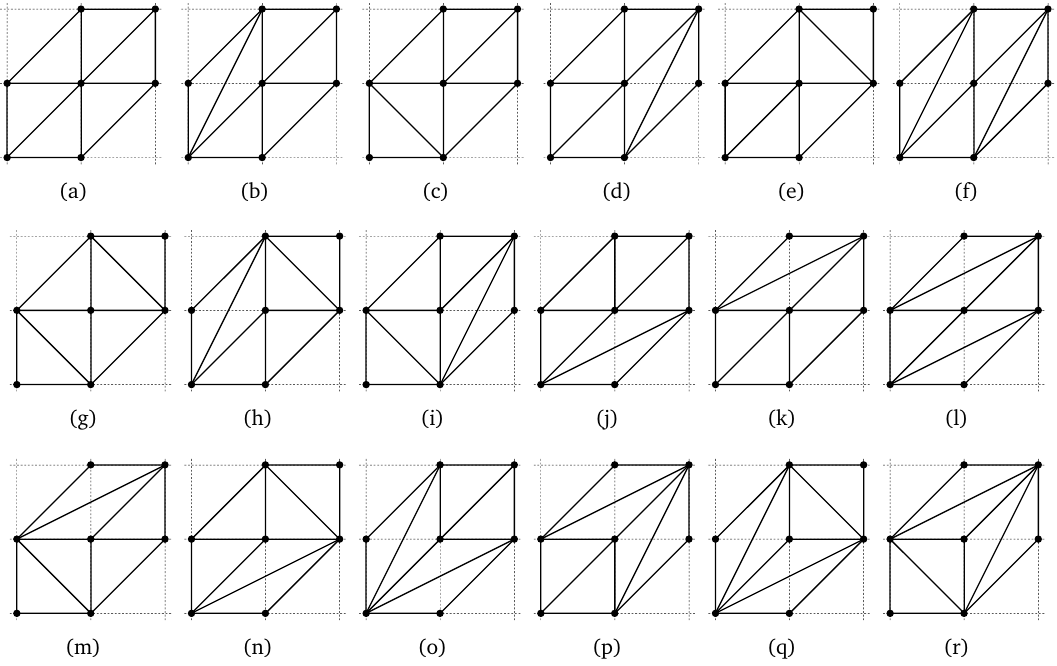
Figure 11: The 18 resolutions of the E singularity. The 9 resolutions (a)-(i) admit 3 a vertical reduction. There are also 9 resolutions that admit an horizontal reduction (namely: (a), (c), (e), (g), (j)-(n)), and 9 resolutions that admit an “oblique” reduc- tion (namely: (a), (b), (d), (f), (g)-(l), (o), (p)). The last three resolutions have no “allowed” IIA